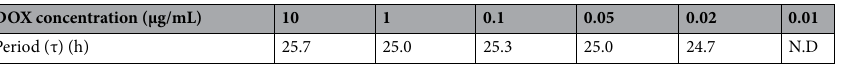
Table 1. Period of P Bmal1 :: Fluc oscillation calculated for each DOX concentration. Data from 0 to 144 h shown in Fig. 1B were detrended using 6th-order polynomials and subjected to a chi-square periodogram analysis using Lumicycle analysis software (ActiMetrics; Wilmette, IL, USA).